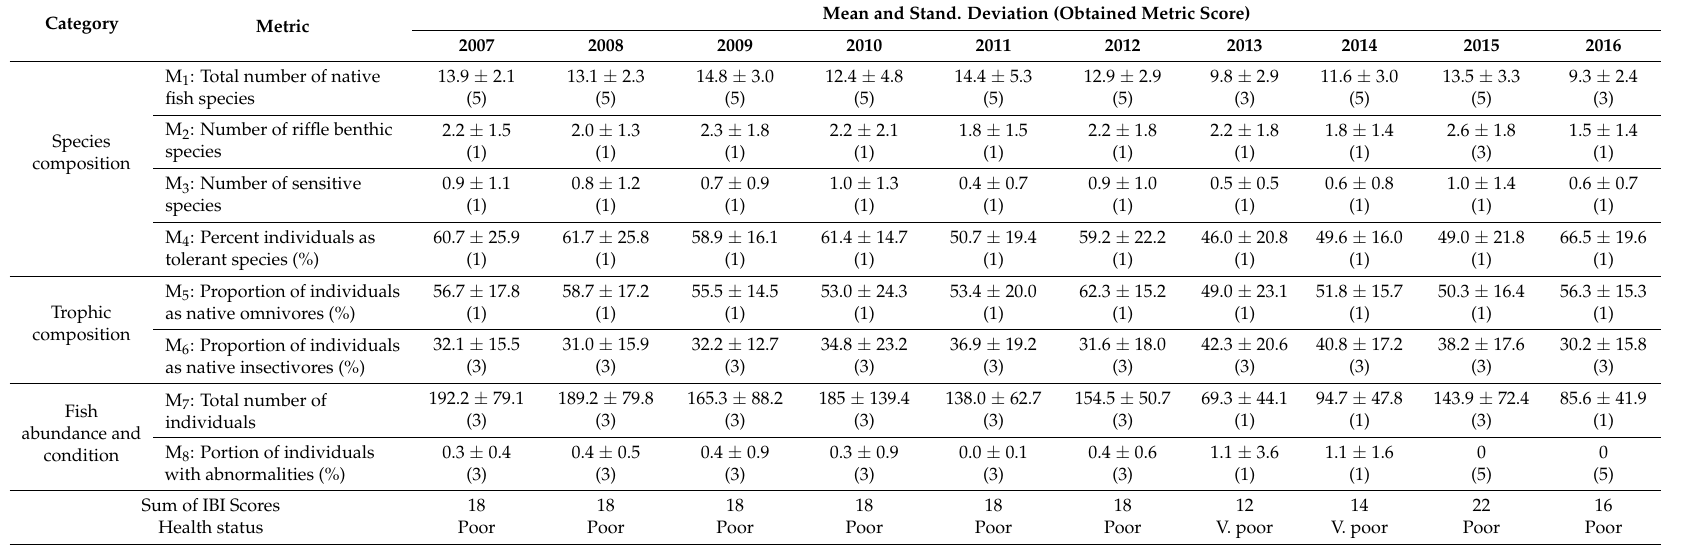
Table 6. Annual results of index of biotic integrity (IBI) and biological health evaluation in Gap Stream during